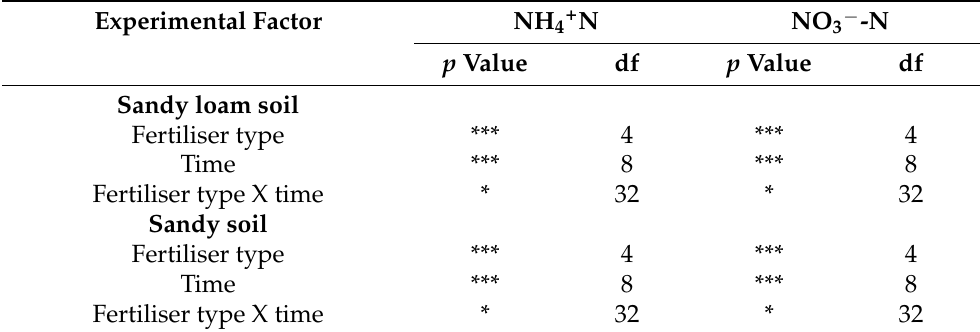
Table 2. Effect of fertiliser types, time, and their interaction on soil ammonium and nitrate concentra- tions in the two soil